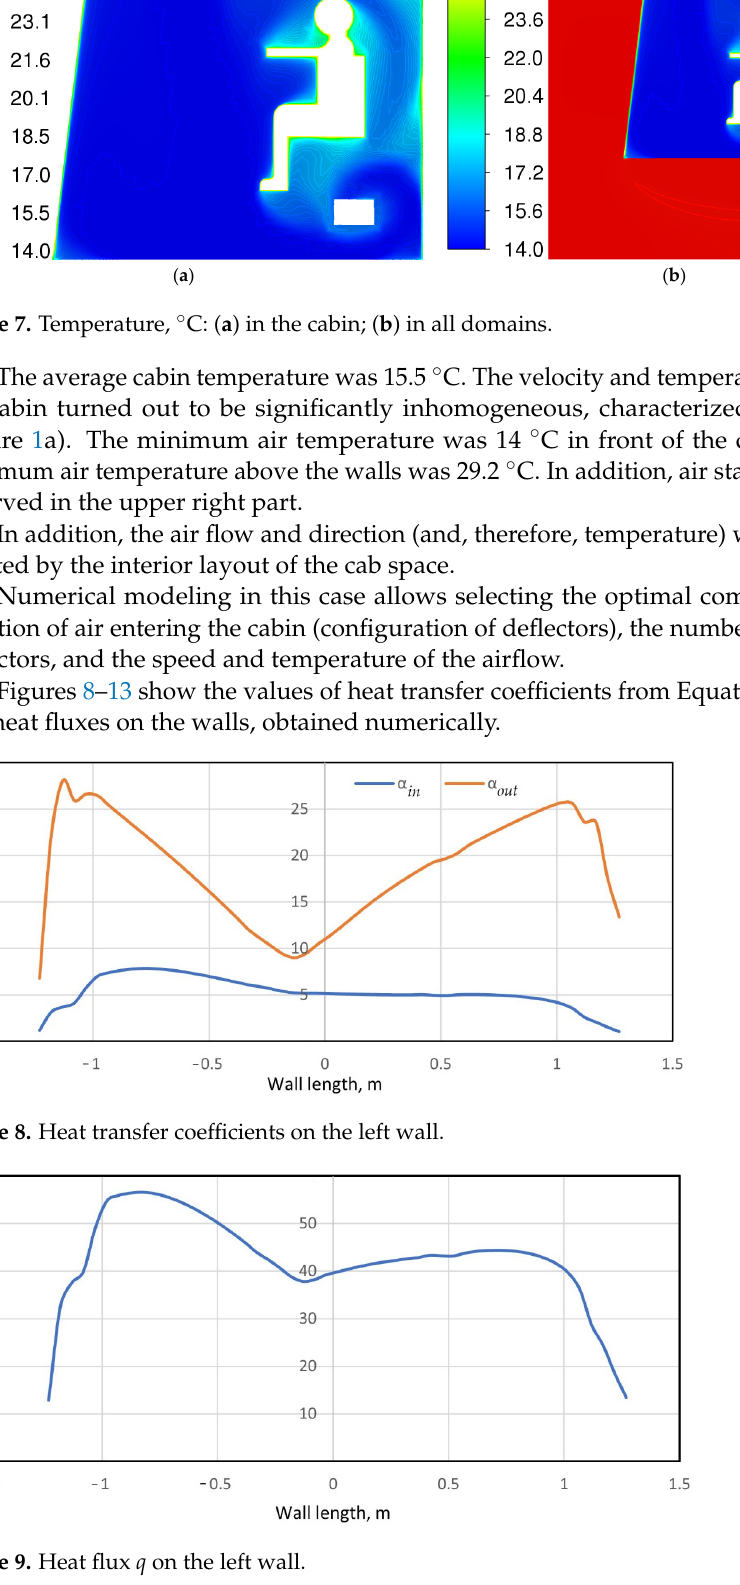
Figure 6. Vector velocity field, m/s: ( a ) in all domains; ( b ) in the cabin (directions and quantitative values of the parameters are shown by arrows in accordance with the color palette).